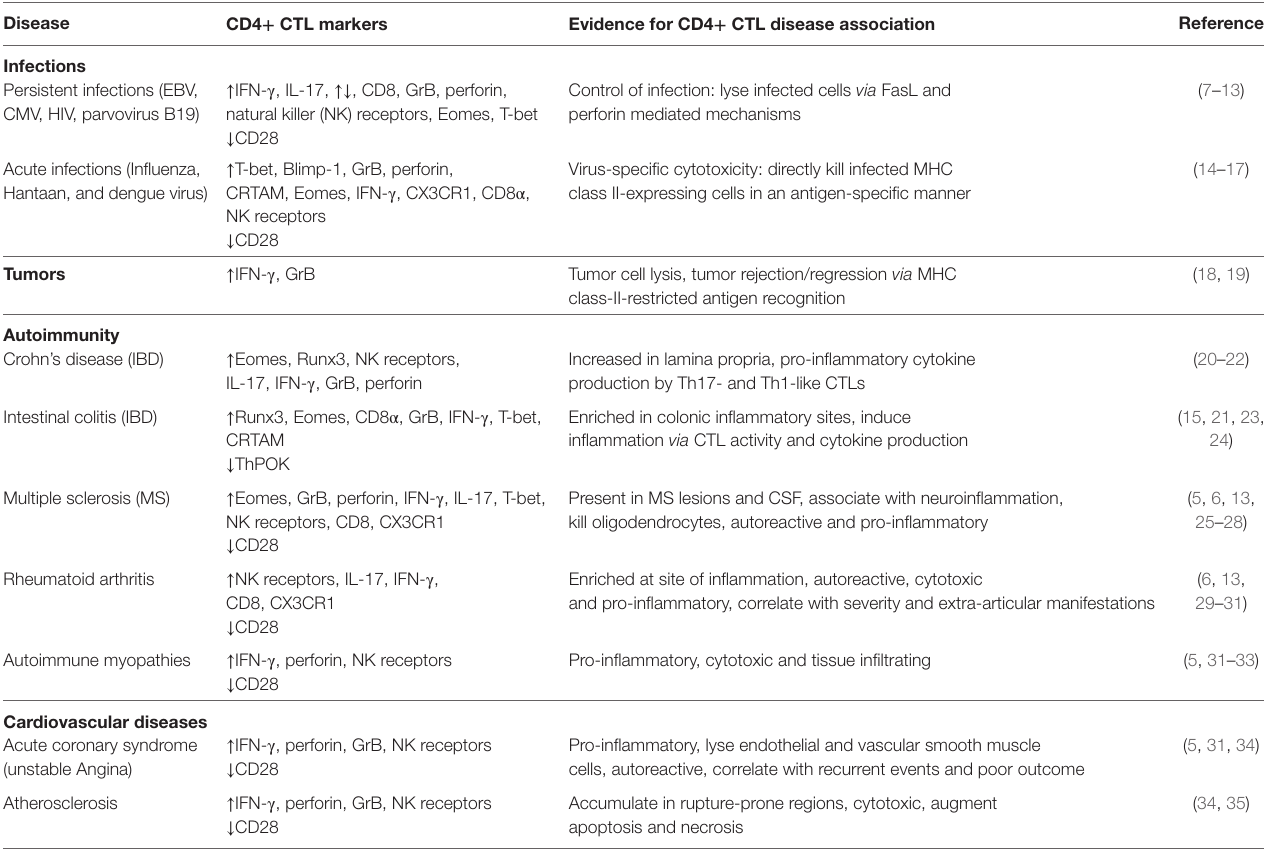
table 1 | Involvement of CD4 + CTLs in different diseases.